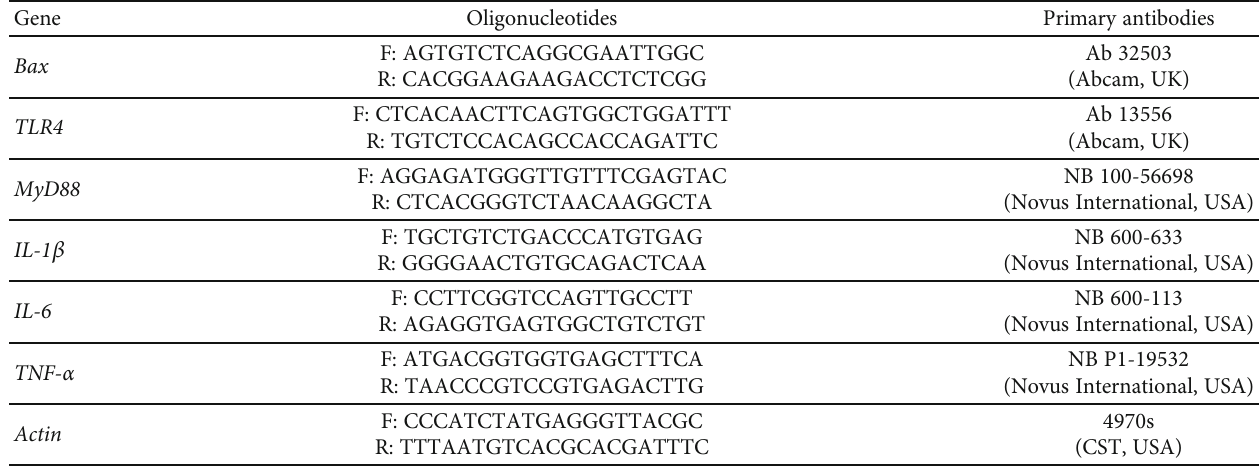
Table 1: List of PCR primers and the primary